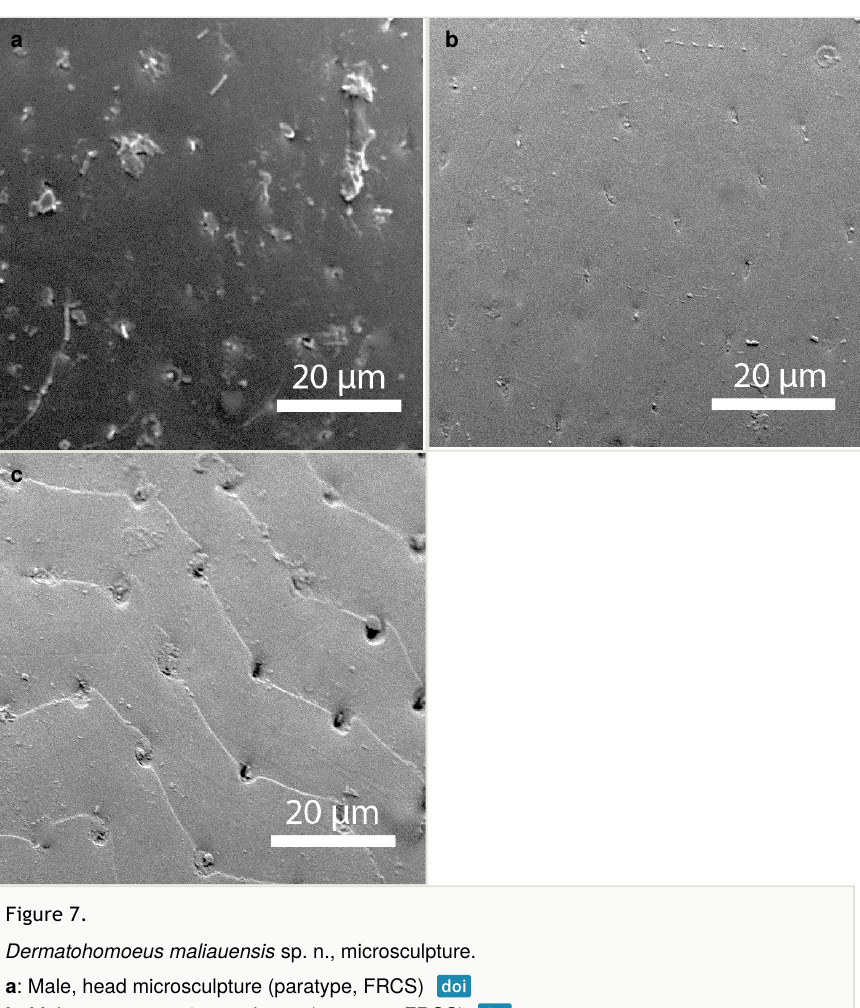
Elytra : Broadest at the shoulders, roundly curved to apex. Elytra with distinct punctuation. Punctures separated by ca. 3x their own diameter, here and there arranged into longitudinal rows. All punctures connected by jagged horizontal striae that are spaced ca. 20 µm apart. Elytra with sparse hairs emerging from the punctures; these hairs are short, about as long as the width of antennomere III (Fig. 7c). Aedeagus : Median lobe in dorsal view gradually narrowing towards the apex, terminally shaped into a broad, mushroom-shaped plate that is twice as wide as long (Fig. 8a). The apical angles of the ventral piece can be seen emerging on either side of this plate. Parameres reach the level of the basis of this plate. The dorsal surface of the terminal one-third of the median lobe is covered in coarse granules (only visible with